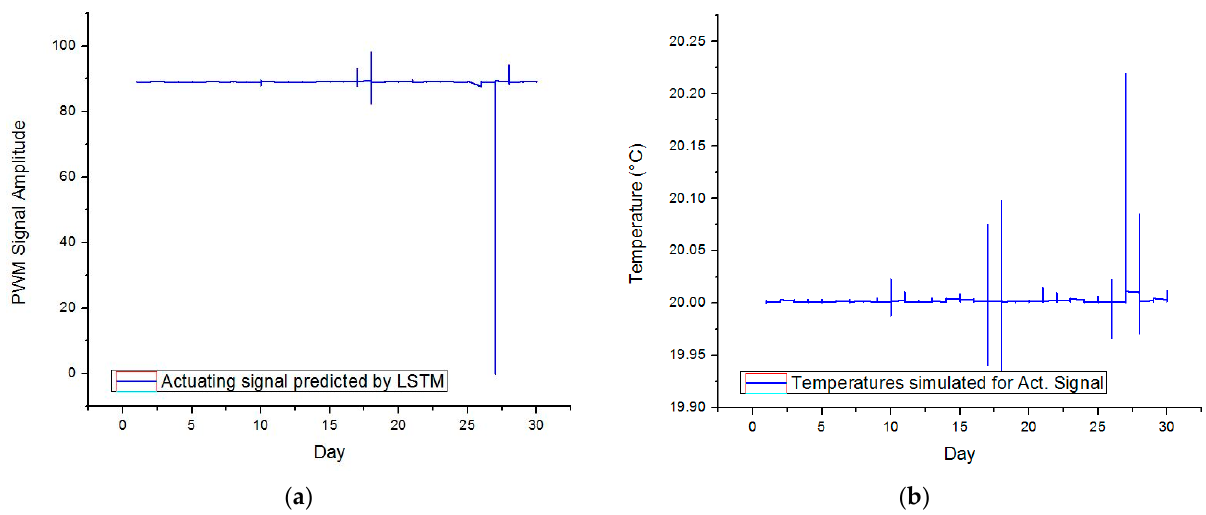
Figure 24. ( a ) The actuating signal predicted by LSTM and ( b ) the simulated